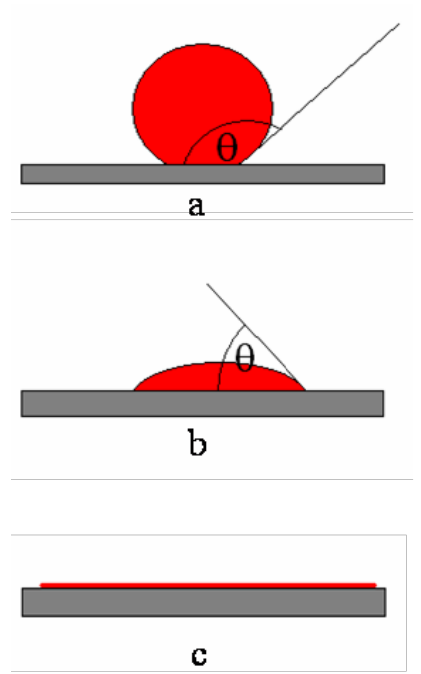
Figure 2. Interpretation of contact angle: ( a ) non-wetting; ( b ) wetting; ( c ) in case of perfect wetting.